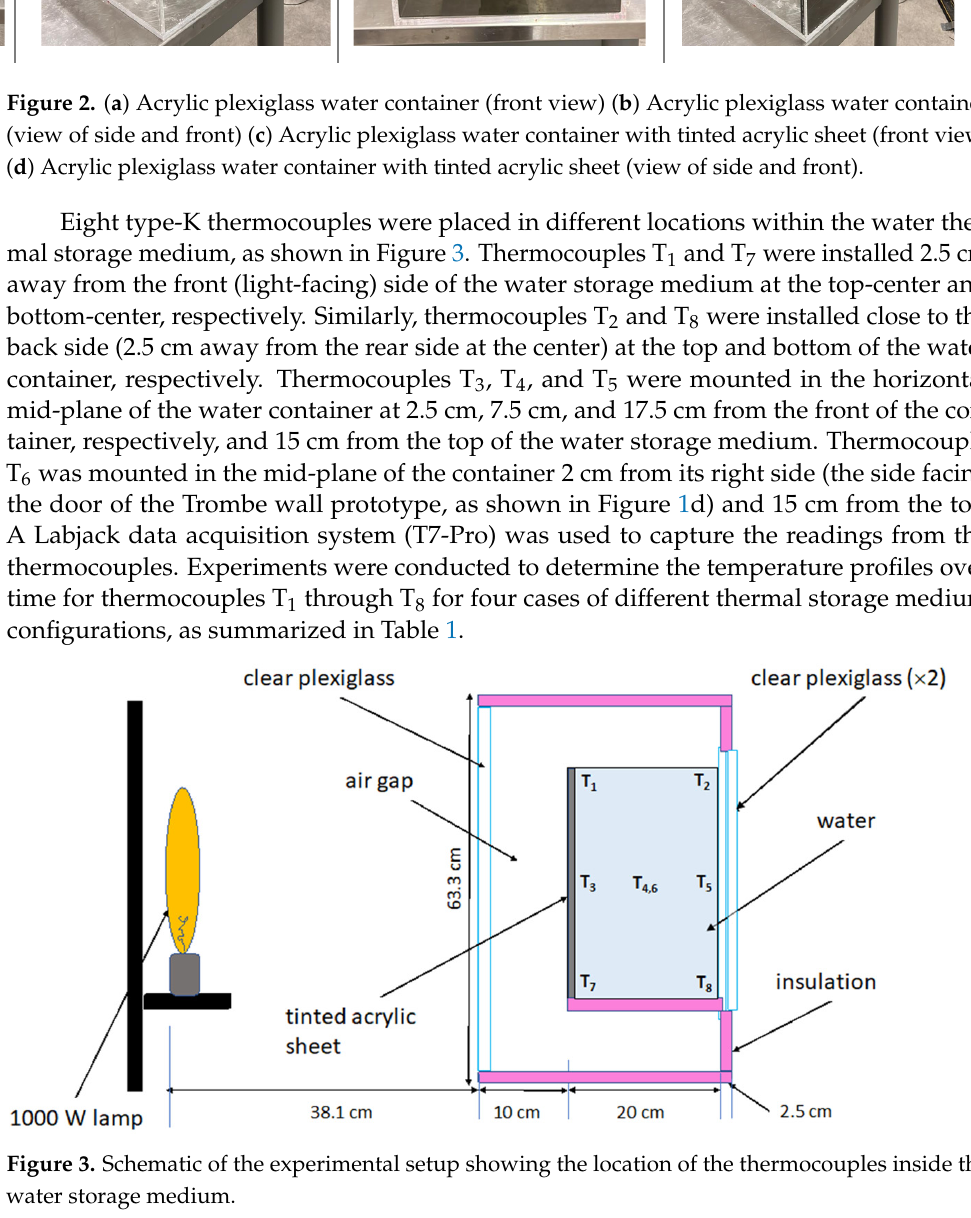
Figure 2. ( a ) Acrylic plexiglass water container (front view) ( b ) Acrylic plexiglass water container